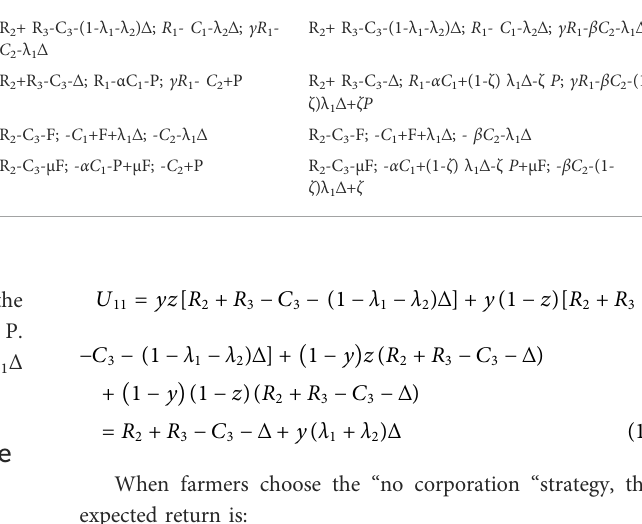
Farmers Cooperation